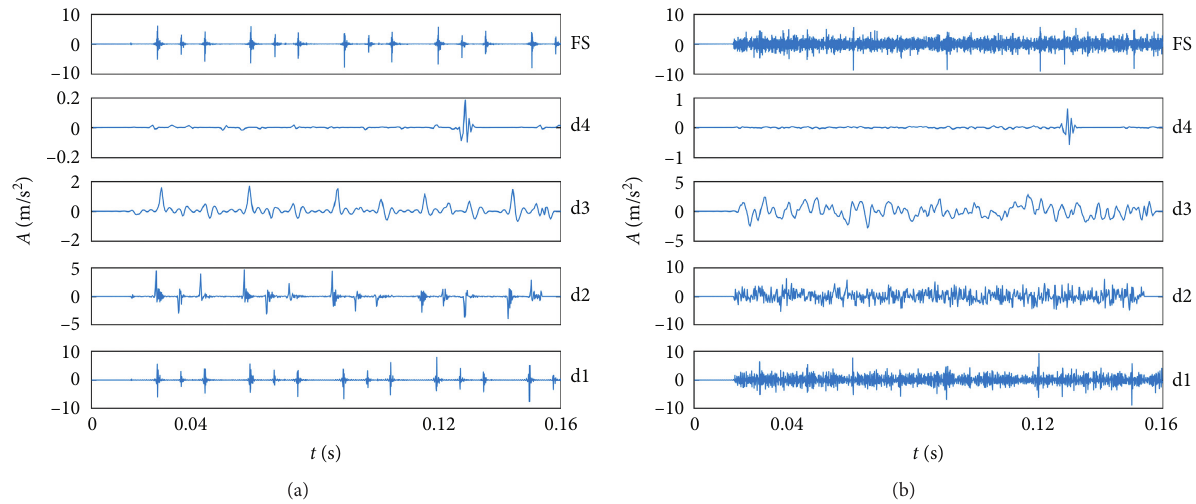
Figure 13: The results of the engine single-cylinder misfire fault signal processed by wavelet decomposition. (a) Noiseless. (b) Under 5dB noise.